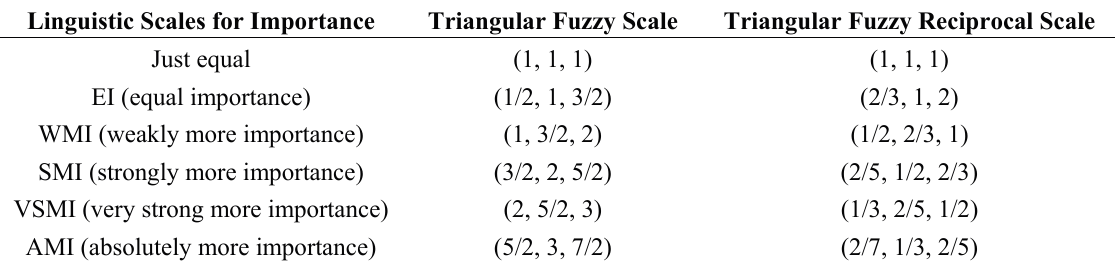
Table 5. Linguistic scales and fuzzy scales for importance.